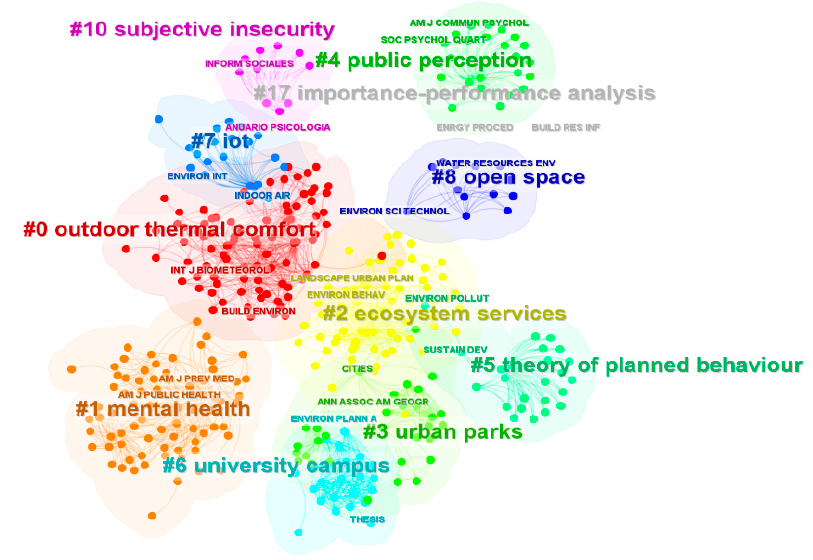
Figure 2. Clustering keywords from 2000 to 2021 of the co-cited